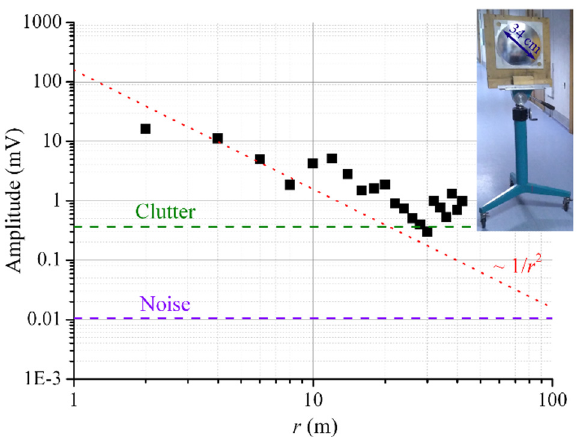
Figure 5. The amplitude of the BF signal in dependence on the range to a reflector ( r ). The black points are the experimental data; the red dotted line is an approximation by the function C / r 2 , where C is a fitting parameter. The green dashed line is the level of the clutter; the violet dashed line is the level of the receiver noise. Inset: a photograph of the reflector.